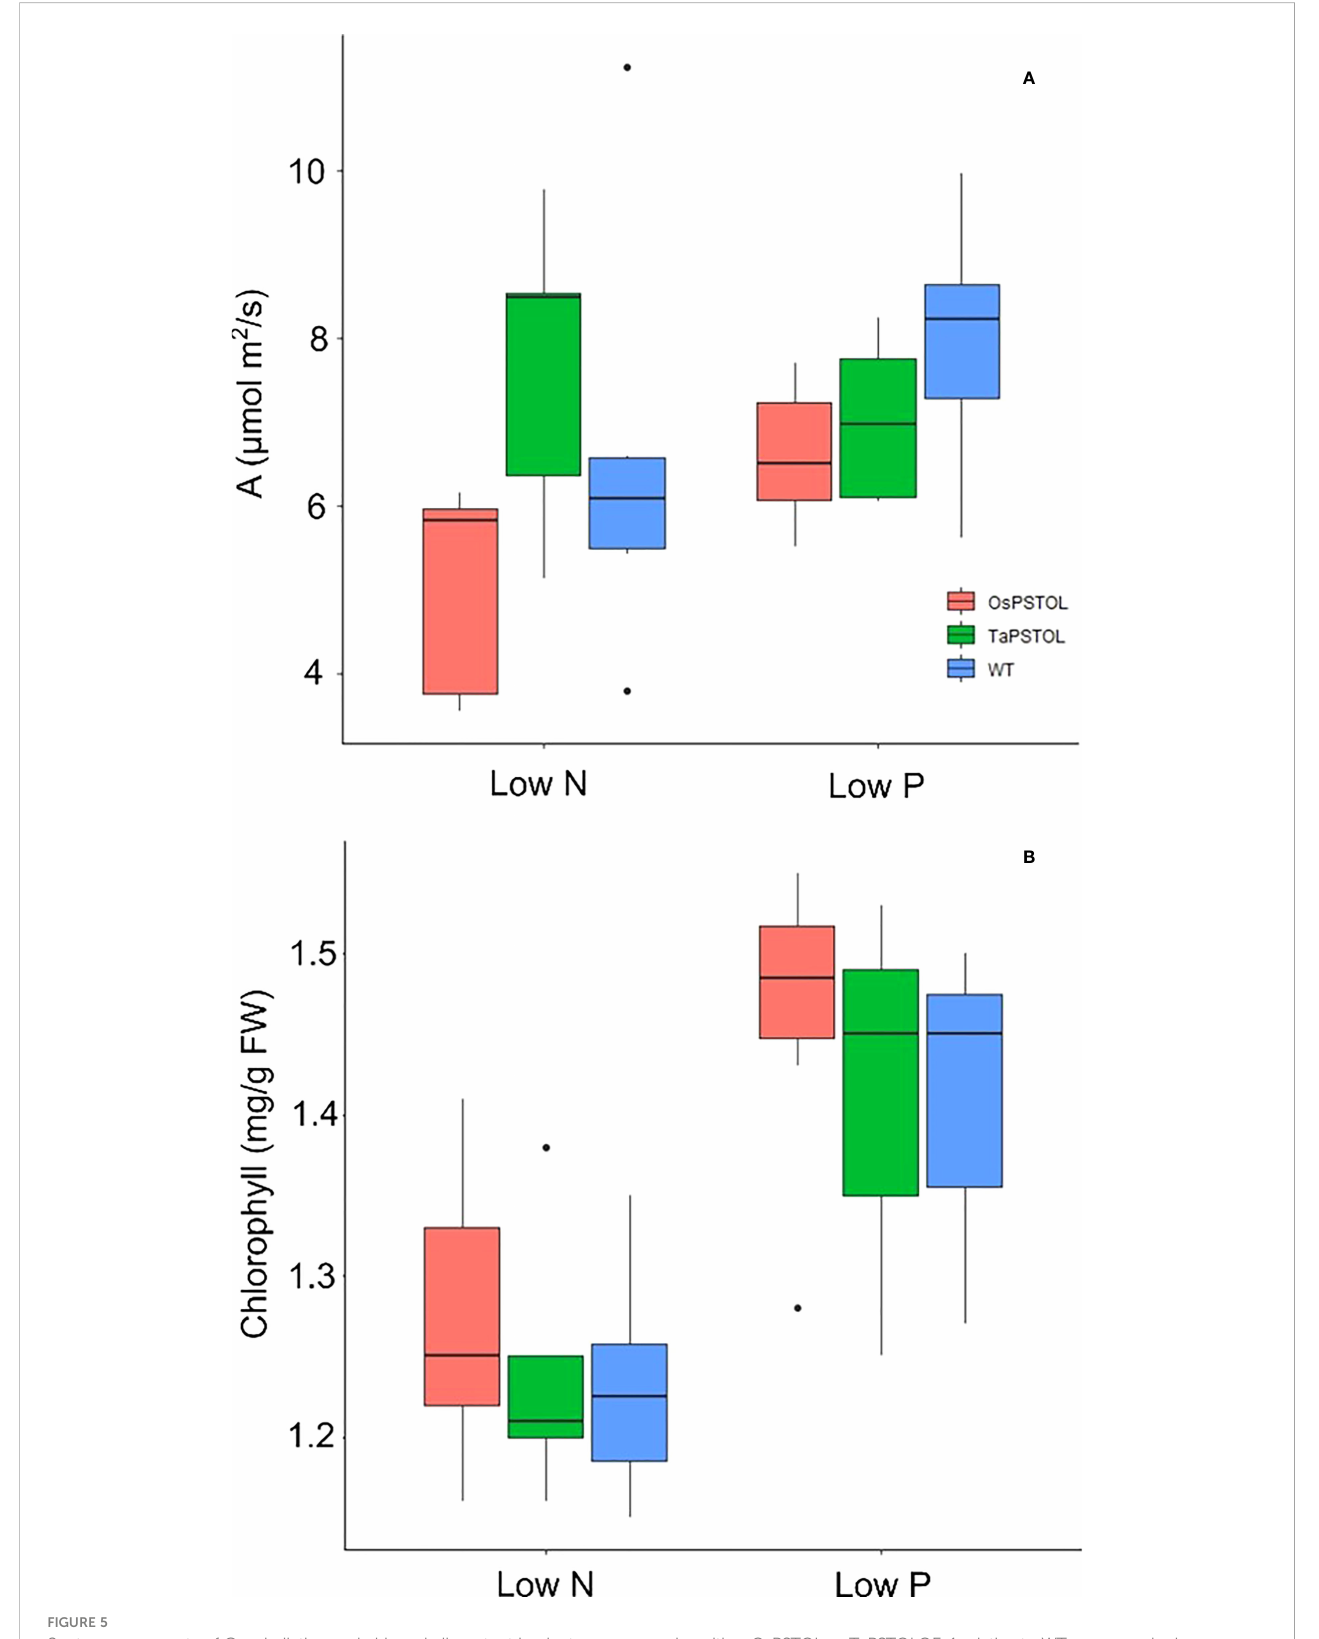
FIGURE 5 Spot measurements of C assimilation and chlorophyll content in plants overexpressing either OsPSTOL or TaPSTOLOE-1 relative to WT grown under low nitrogen (low N) or low phosphate (low P) conditions. (A) Spot measurements of C assimilation grown in growth chamber conditions which include a light intensity of 250µmolm 2 /s and CO 2 level of 400 ppm. (B) Chlorophyll content of plants grown under low nitrogen (low N) or low phosphate (low P)